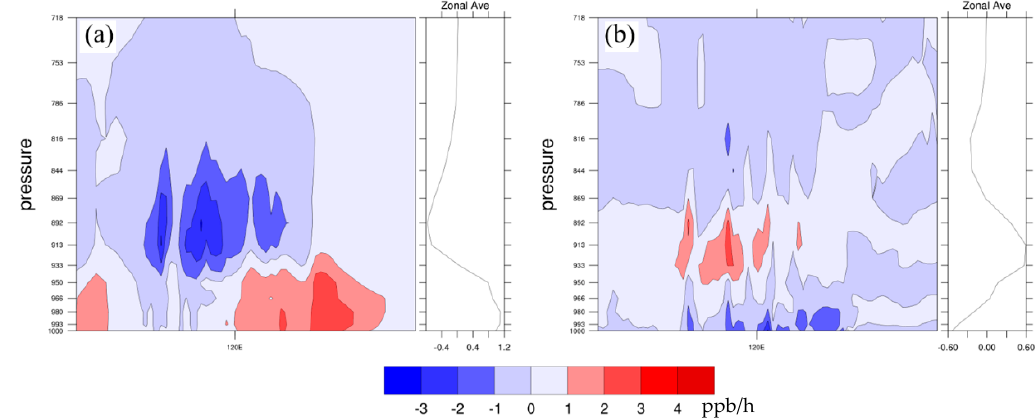
Figure 7. The spatial distribution of monthly averaged differences of ( a ) Chem_O 3 , ( b ) Advt_O 3 , and ( c ) Vmix_O 3 between FUTMET and PREMET during the daytime (from 7:00 to 18:00 LST). Chem_O 3 represents the O 3 chemical production process. Vmix_O 3 means the contribution of vertical mixing and dry deposition to O 3 . Advt_O 3 means the contribution of horizontal and vertical advections.